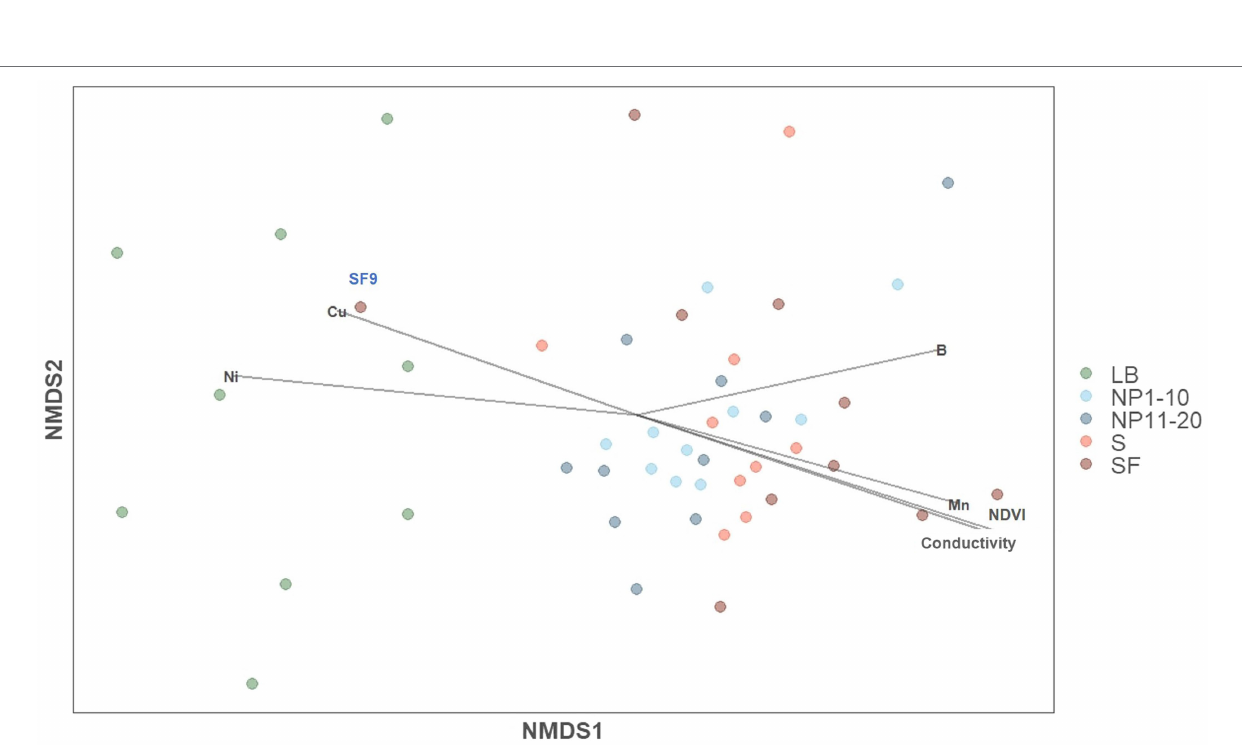
FIGURE 2 | Impact of physiochemical factors on bacterial community composition (NMDS analysis based on Bray-Curtis distances). NMDS stress = 0.132. LB: ridge from the catchment with human transit. NP 1–10: open spaces from the unaffected catchment. NP 11–20: forested area from the unaffected catchment. S: paths from the catchment with human transit. SF: forest areas from the catchment with human